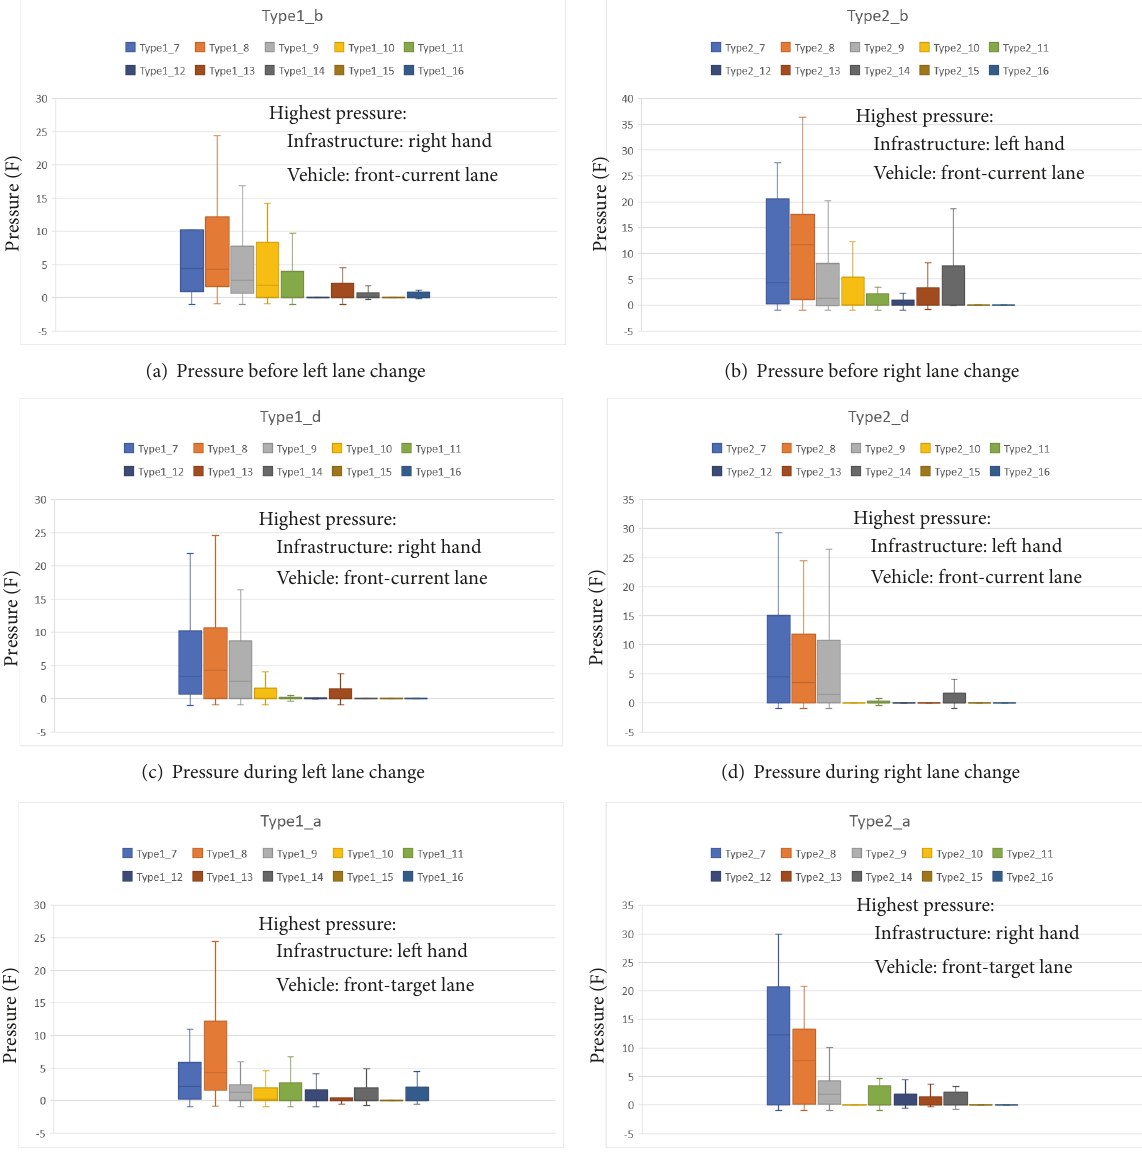
Figure 8: Vision pressure of lane-changing behaviour (the numbers in the legend refer to Table